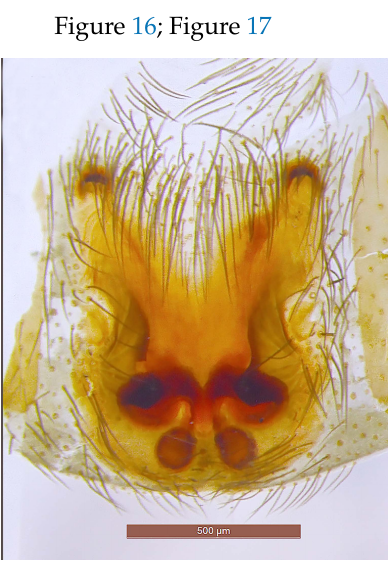
Figure 16. Zelotes olympi , epigyne (FC: 17048).